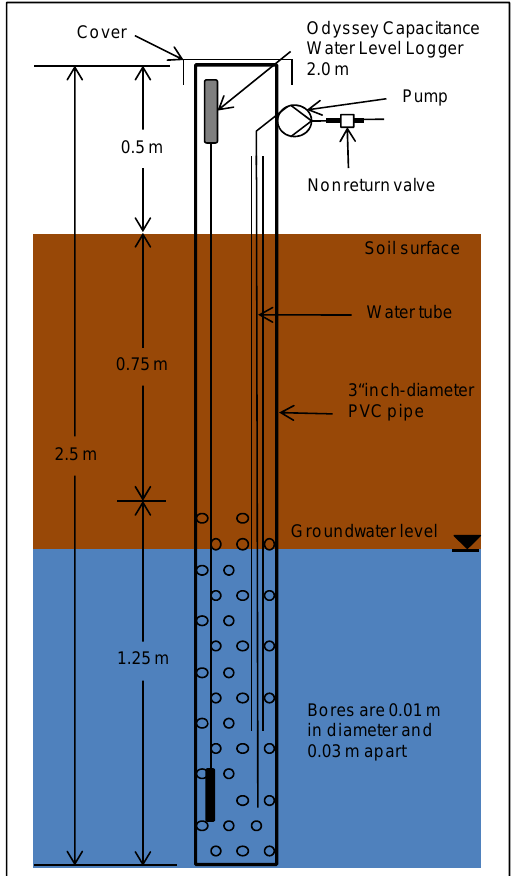
Figure 4. Groundwater piezometer for water sampling and monitoring of groundwater table depths. Each piezometer is equipped with a sampling pump, nonreturn valve and capacitance water